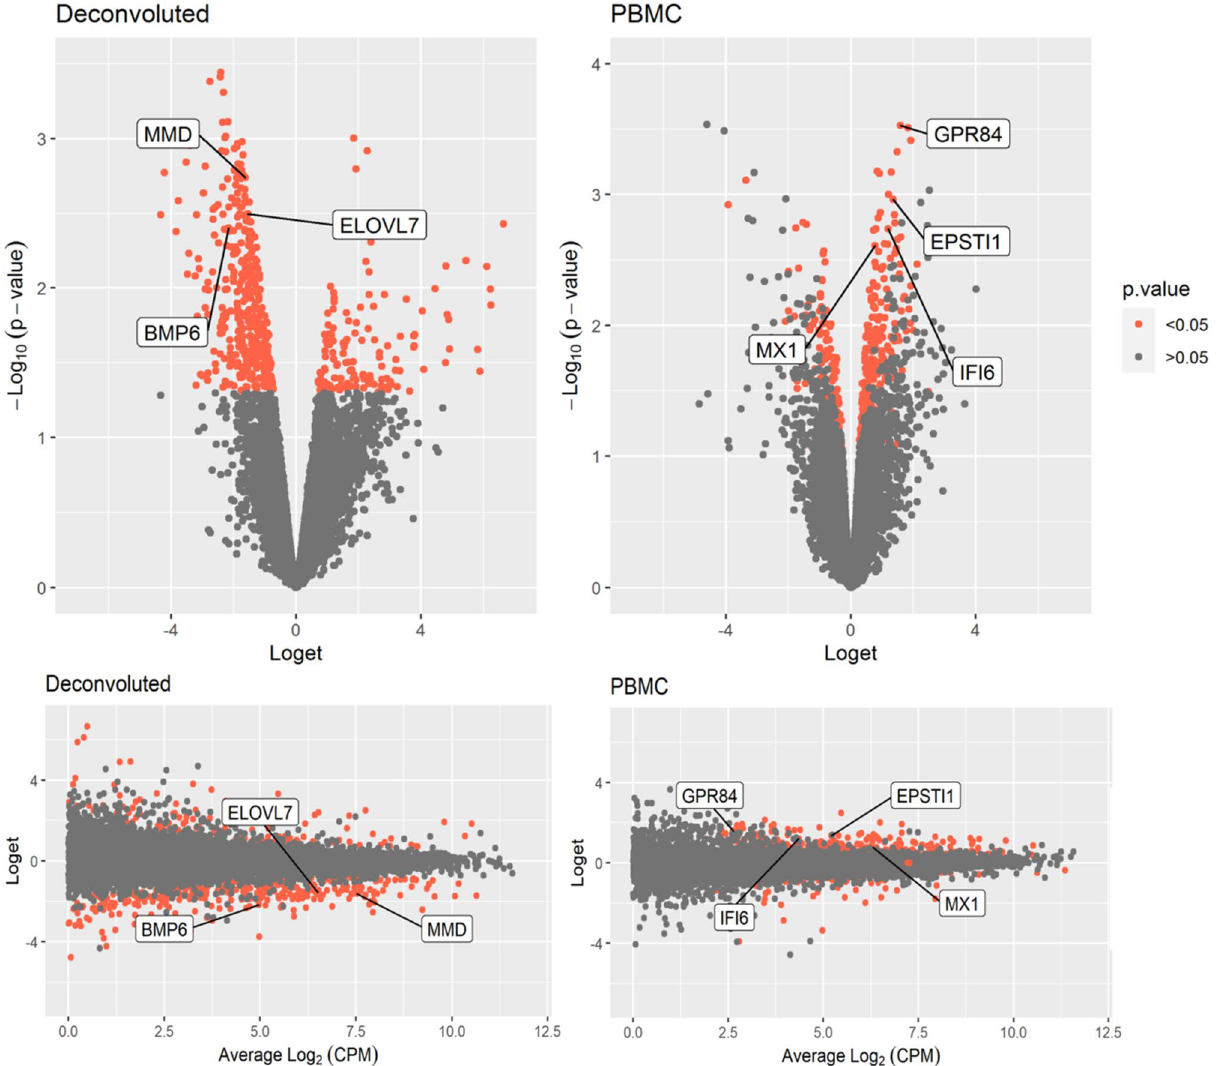
Figure 1. RNA-seq volcano and smear plots of RNA-seq analyses. RNA-seq analysis. The plots were constructed using ggplot2 R package 23 .